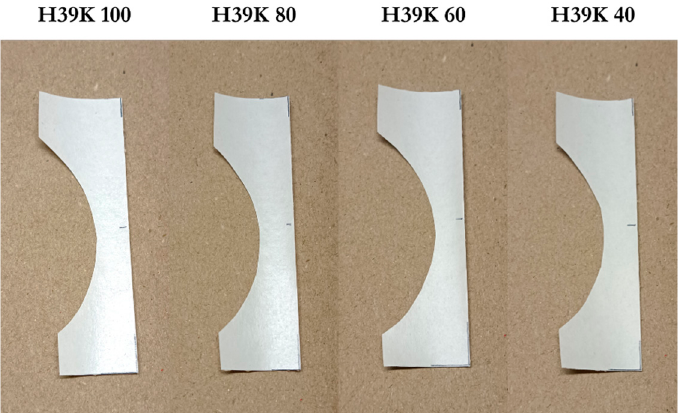
Figure 10. Different qualitative glossiness for H39K 100, H39K 80, H39K 60, and H39K 40 coatings over KB—pictures taken in the same light conditions. As the kaolin content increases, the coated surface reduces its glossiness—as visible in the lower half of the samples—giving a soft touch aesthetic aspect.